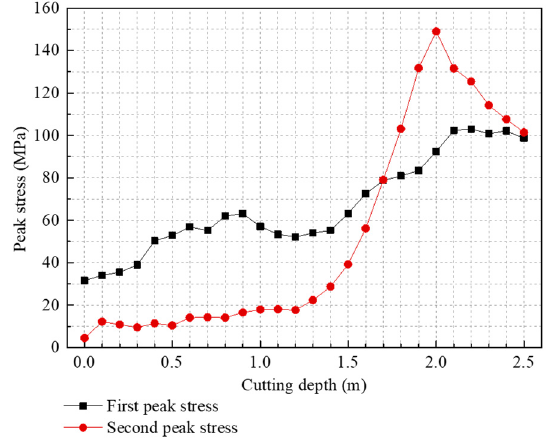
Figure 9. Variation curve of the peak stress with the cutting depth.